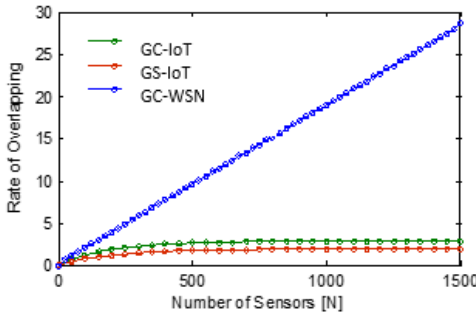
Figure 14. Overlapping rate comparison.